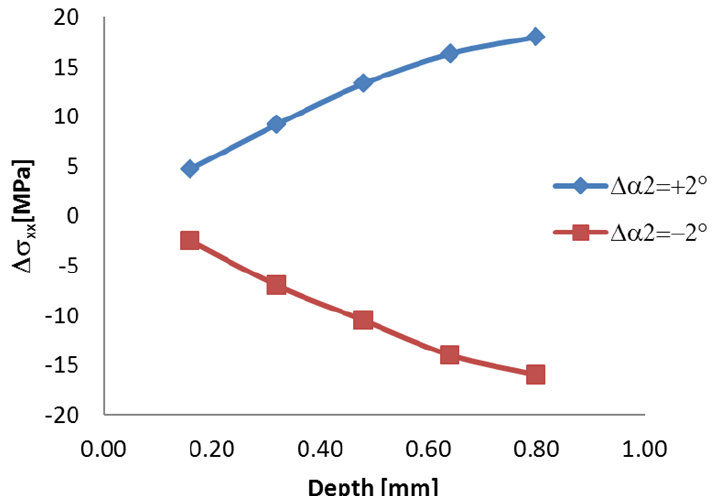
Figure 4: Differences in calculated stress in correspondence of an error of Δα 2=+2° (rumble, blue dots) and Δα 2 =-2° (squared, red dots) with respect to the measured